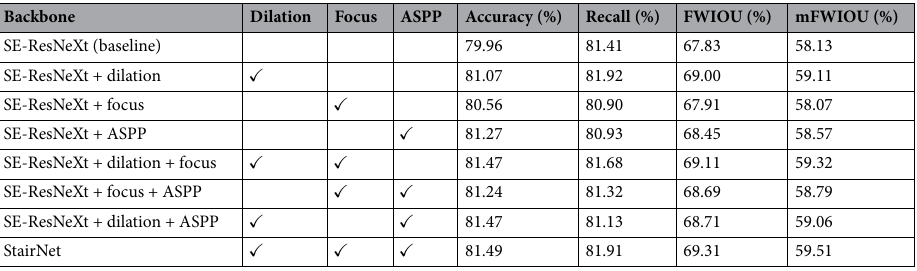
Table 2. Results of ablation